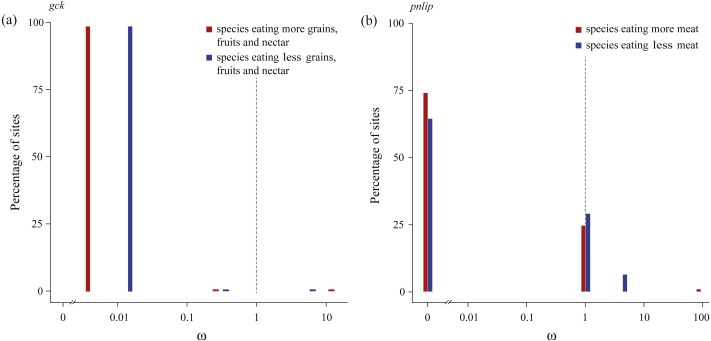
Patterns of natural selection on the carbohydrase gene gck and the lipase gene pnlip.All ω values were estimated by the best fitting models, with percentages of sites from each ω category plotted in blue (test branches) and red (reference branches). The gray vertical and dashed lines at ω = 1 indicates neutral evolution.